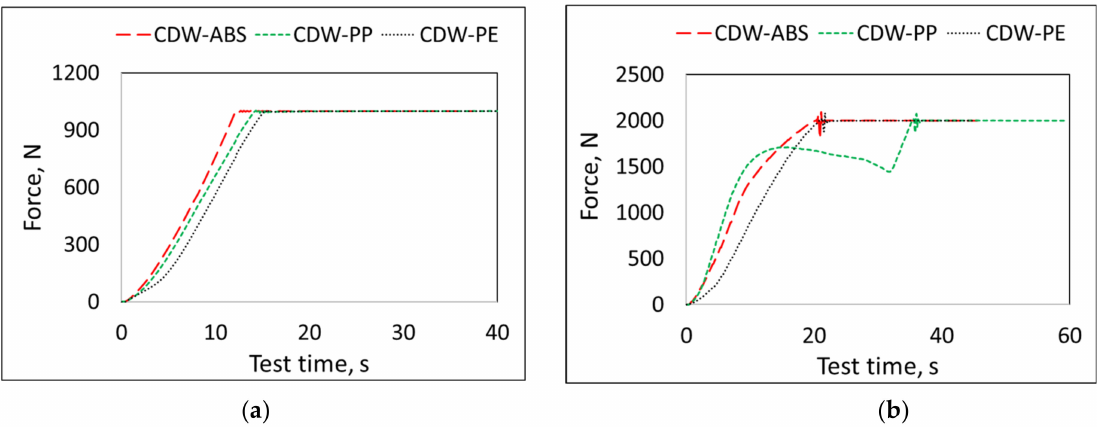
Figure 4. The strength curves of Brinell hardness ( HB 1 ) ( a ) and resistance to indentation ( HB 2 ) ( b ) with various